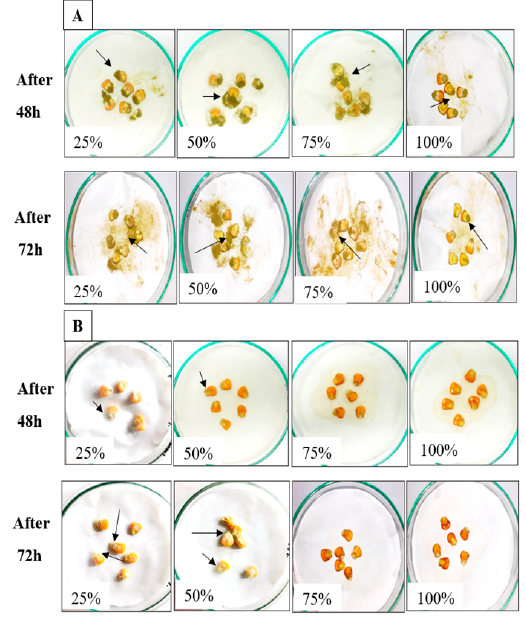
Figure 3. A. flavus growth on raw maize grains soaked with ( A ) MRS broth [25%, 50%, 75% and 100% ( v/v )] as control and ( B ) L. coryniformis BCH-4 AMCs [25%, 50%, 75% and 100% ( v / v ) AMCs] treated maize grains after 48 and 72 h of incubation at 30 °C. Arrows indicate the white mycelia and/or green spores of A. flavus.